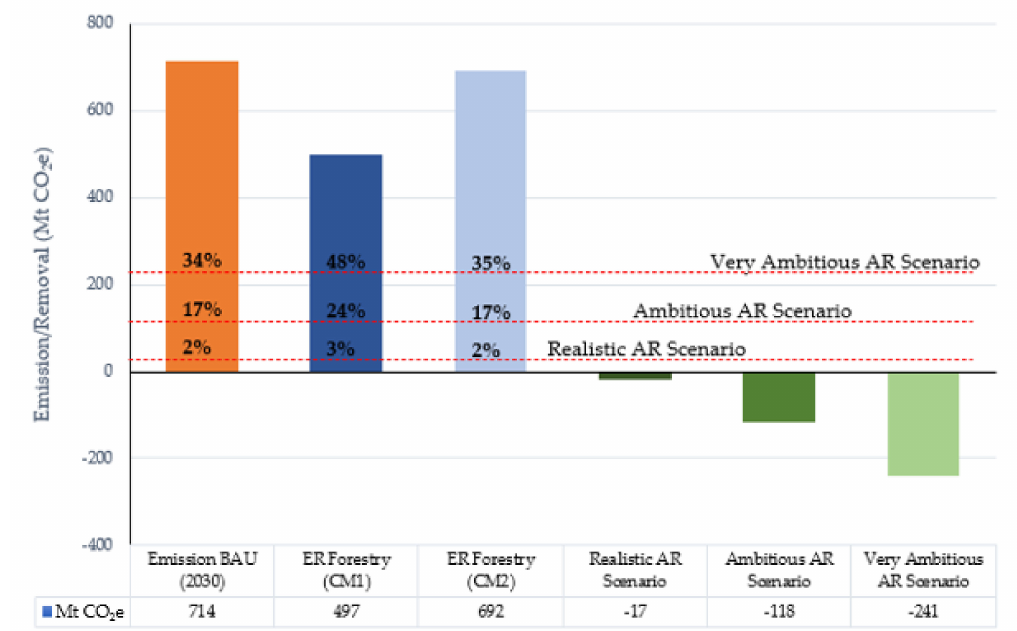
Figure 5. Carbon emission reduction opportunities from reforestation in 2030 with realistic, ambitious, and very ambitious scenarios, and the Indonesia NDC emission reduction target from the forestry sector (BAU, CM1 and CM2